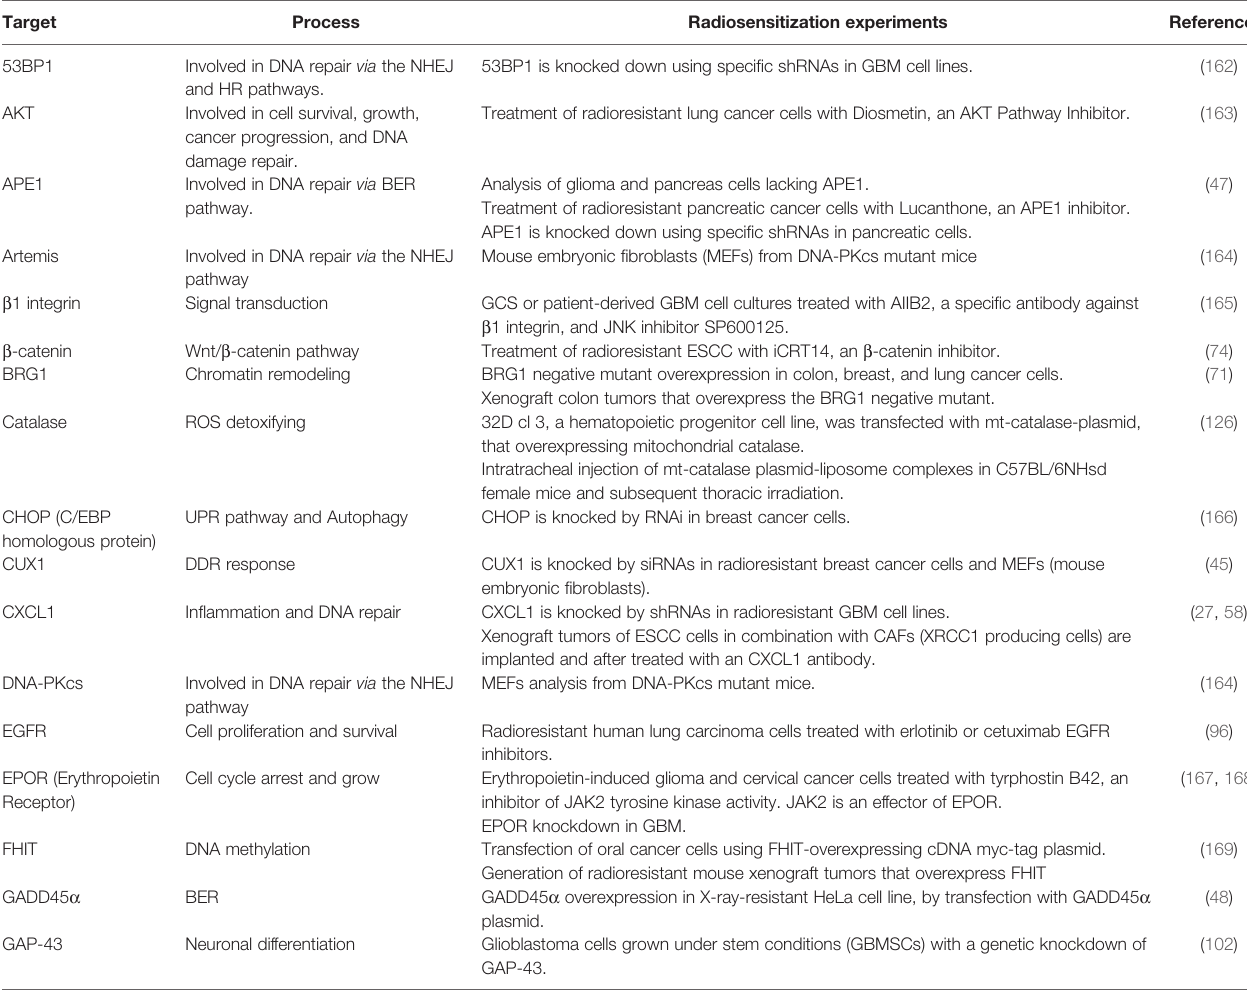
TABLE 2 | Potential molecular targets to enhance radiosensitivity of cancer cells. Target